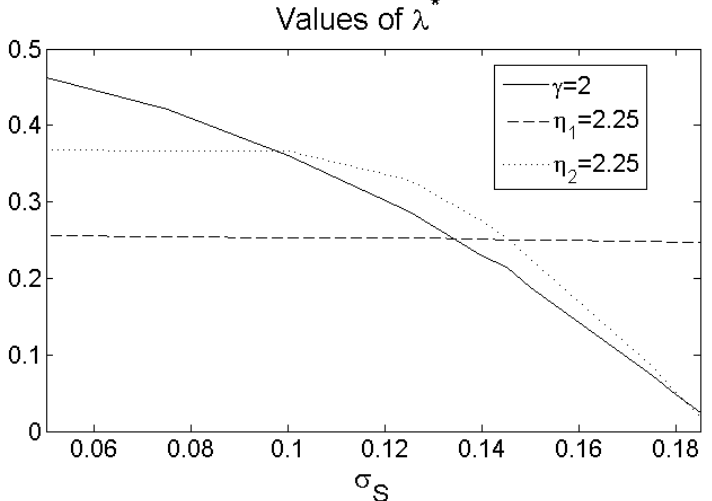
Figure 1. Values for the indifference switching λ ∗ for different levels of the salary volatility σ S